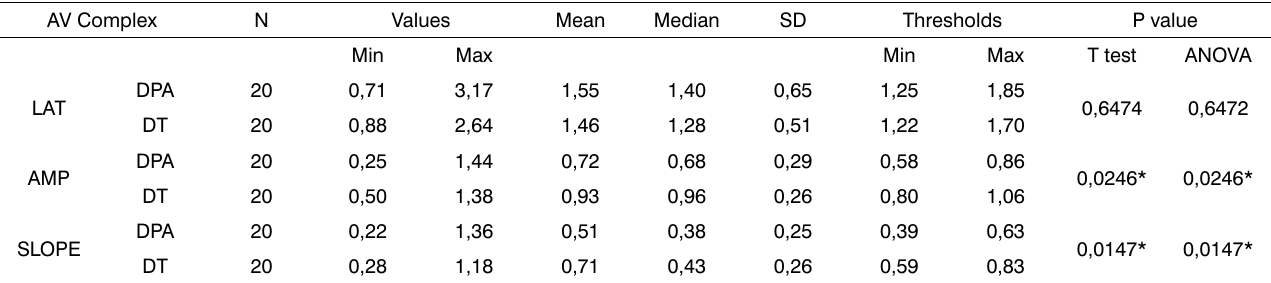
Table 3. Speech stimulus: VA Complex - minimum, maximum, mean, median, standard deviation (SD), confidence interval and p values for latency, amplitude and slope in both